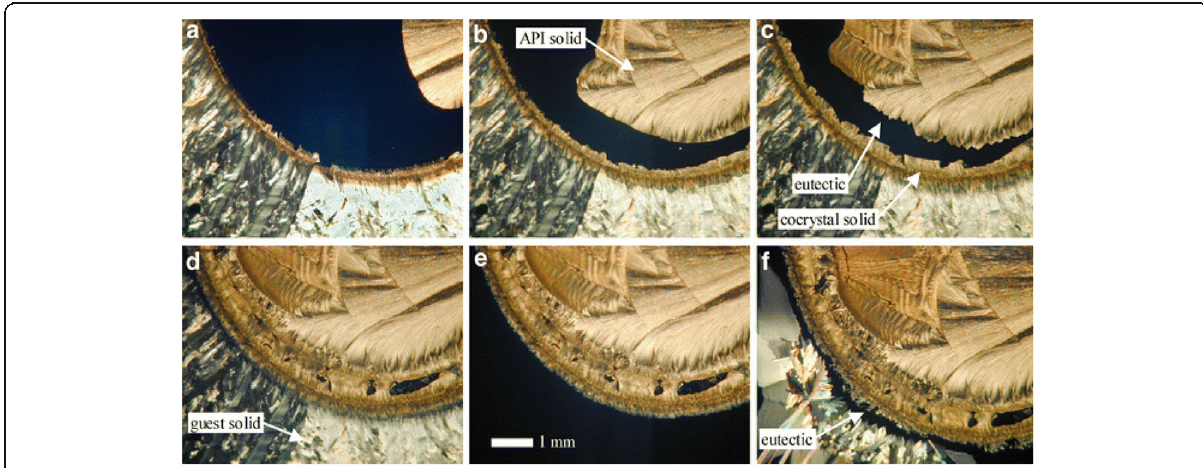
Fig. 5 HSM micrographs of cocrystal screening of API with glutaric acid, the upper half of the micrograph shows the API whereas the lower half is glutaric acid. a, b, c- curved line and dark area at interface depicts cocrystal phase and eutectic phase respectively, d- narrow eutectic area as eutectic melting approaches, e- melting of glutaric acid, f- recrystallization of glutaric acid alongwith eutectic and cocrystal phase. Reprinted from McNamara et al. 2006 with permission from the